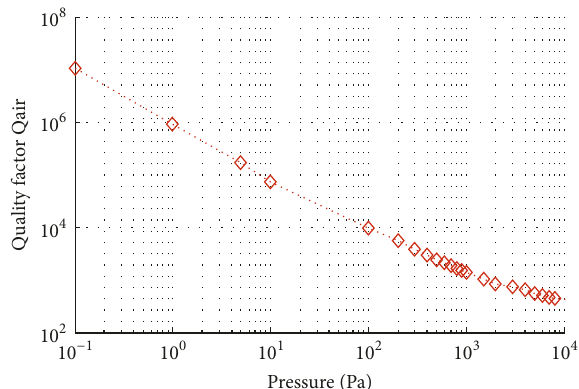
Figure 8: Quality factor Q 20 ∘ C.